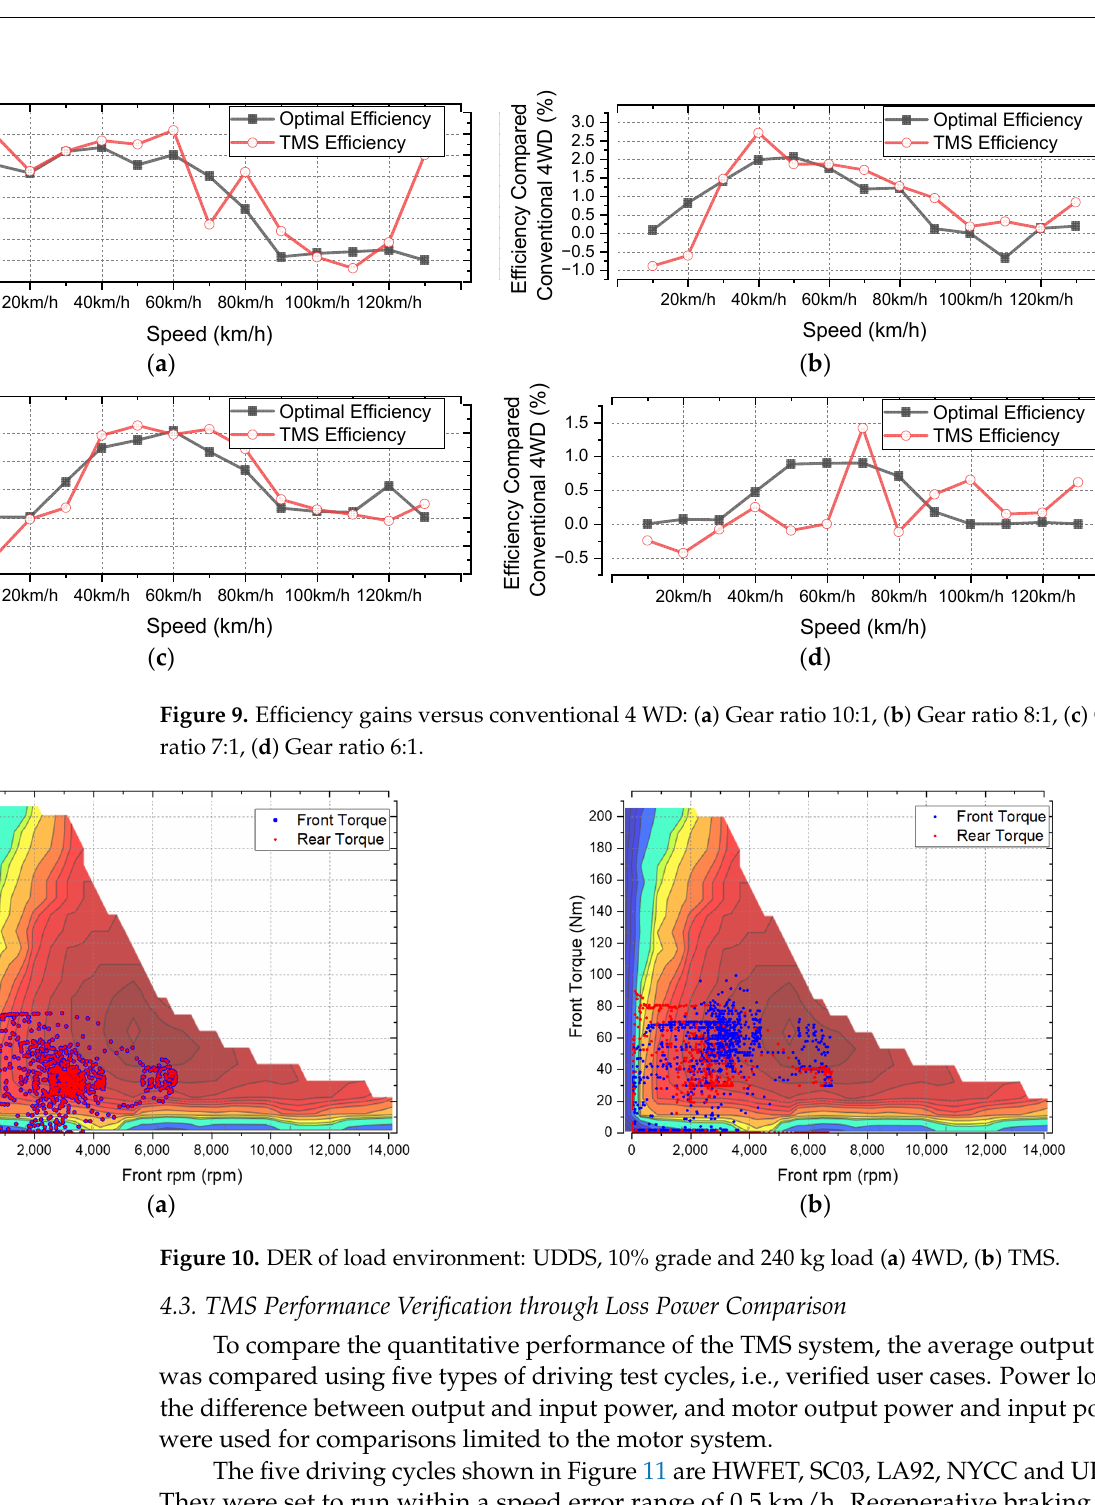
( d ) Figure 8. Torque Distribution ratio of optimal 4WD and TMS: ( a ) Gear ratio 10:1 ( b ) Gear ratio 8:1 ( c ) Gear ratio 7:1 ( d ) Gear ratio 6:1. Figure 9 is a graph comparing the maximum efficiency gain at each gear ratio and the efficiency gain of the TMS controller. The efficiency obtained on the basis of a 50:50